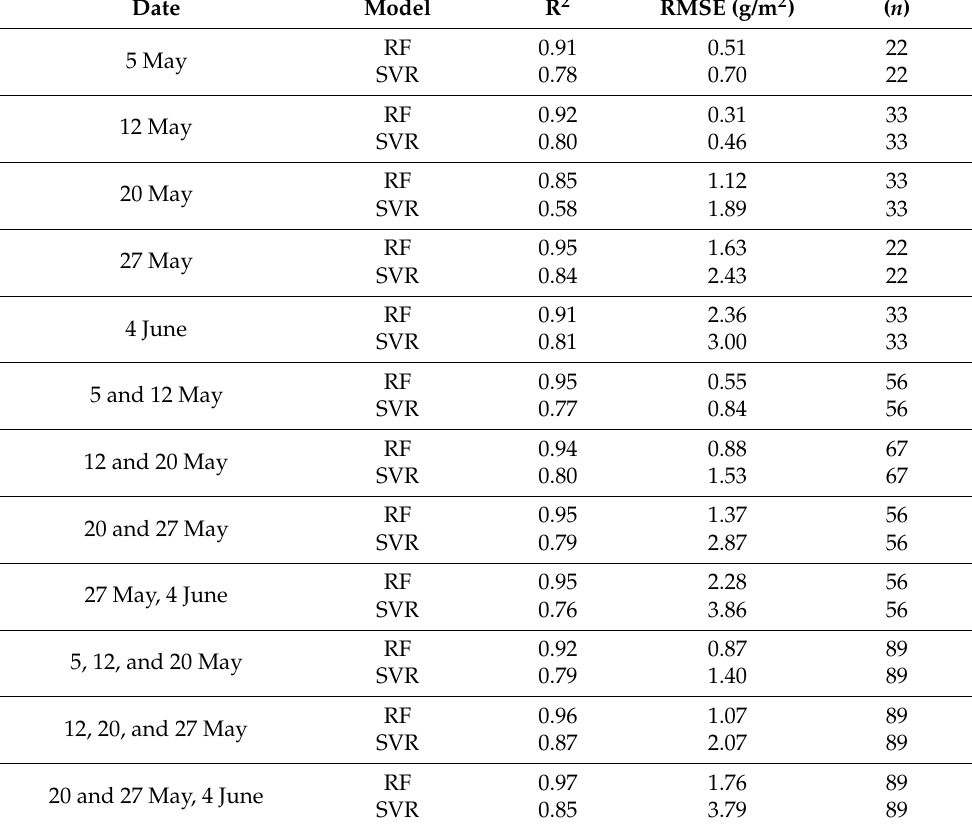
Table 5. Statistics for the calibration of the UAV canopy nitrogen models with 28 variables as a function of the date and modelling approach (RF or SVR) 1 .